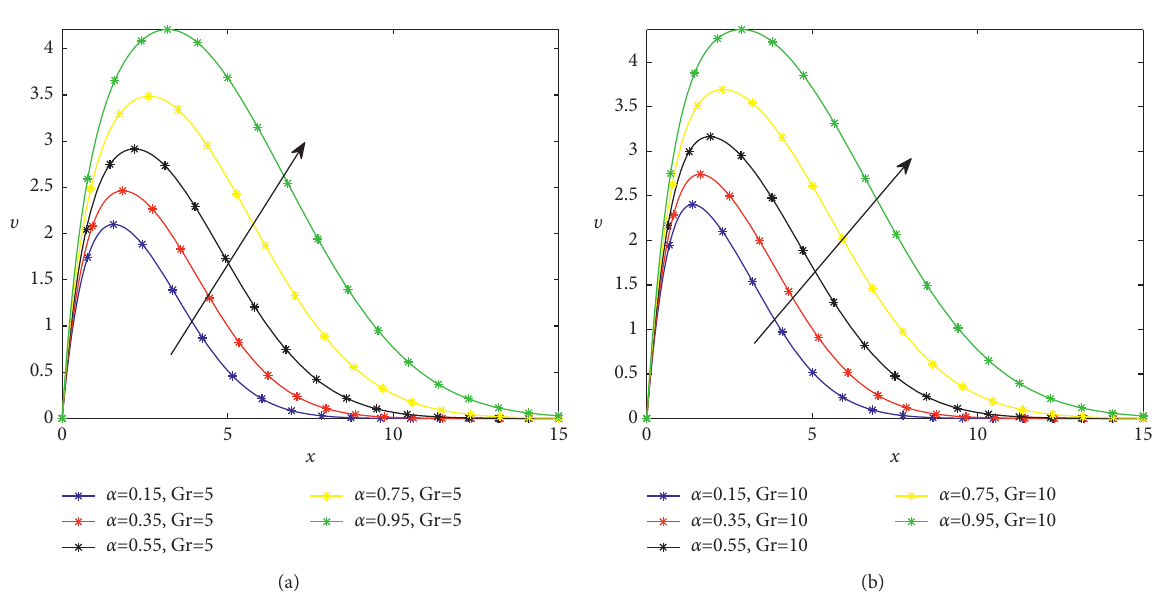
Figure 12: Velocities for different values of order α